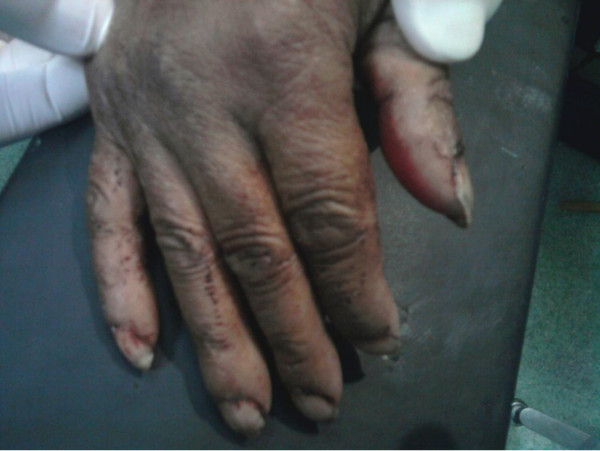
Long fingernails.